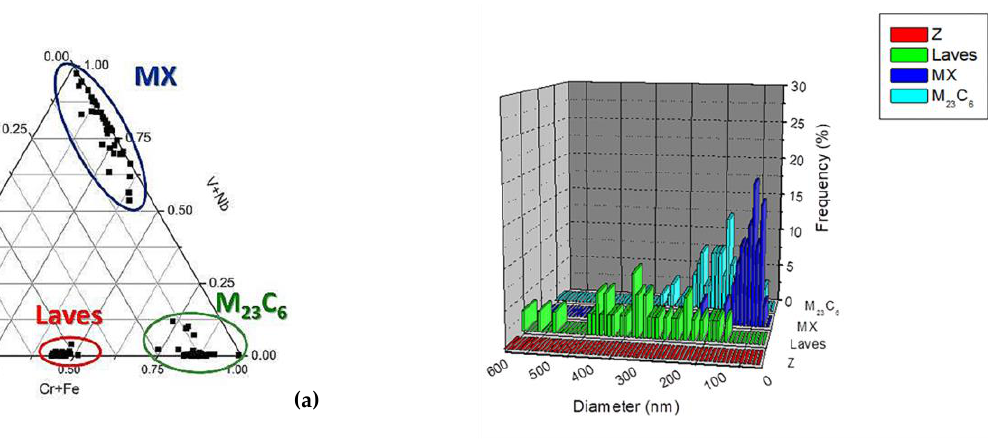
Figure 15. Exposed material specimen 92-EX-1-2 (92 BM 604 ◦ C 43 MPa 74,001 h) (sample E), ternary diagram ( a ) and size distribution ( b ) (TEM